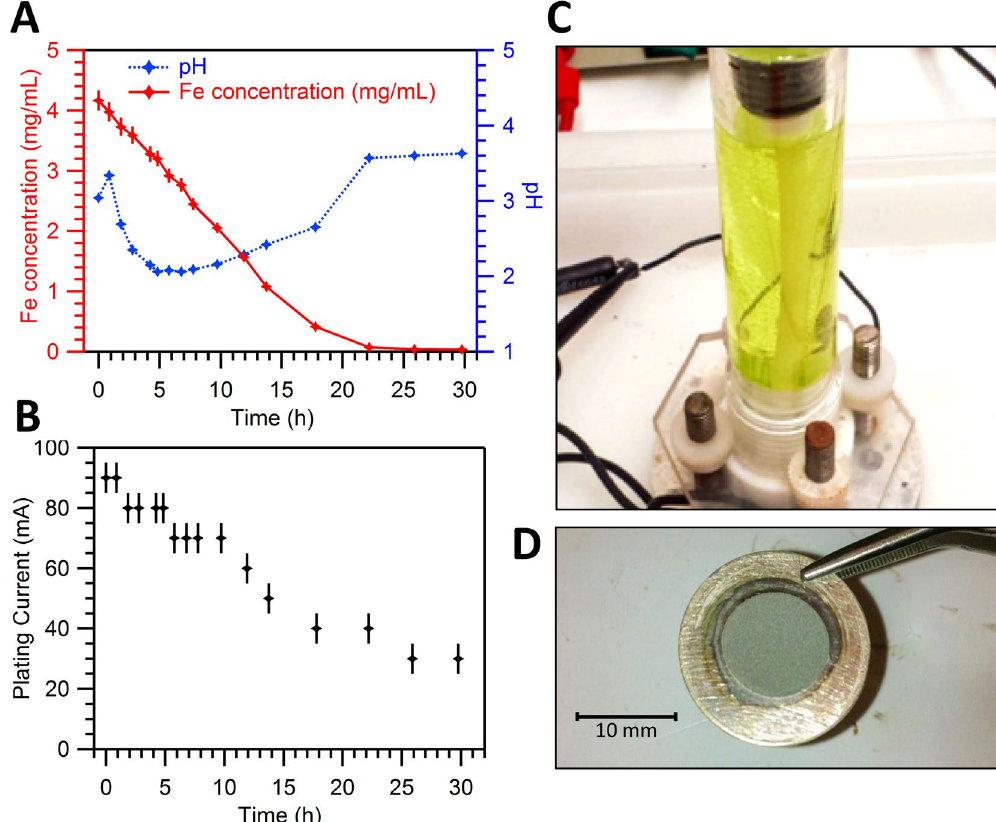
Figure 1. ( A ) Concentration of Fe in electrodeposition solution as a function of time (red) and solution pH as a function of time (blue). Fe concentration was measured by microwave plasma atomic emission spectroscopy (MP-AES). ( B ) Plating current as a function of time with plating potential held constant at 7.0 ± 0.1 V. ( C ) Photograph of plating cell at the start of plating. During plating the light green color becomes colorless. ( D ) Photograph of electroplated 54 Fe target on Ag disc substrate.